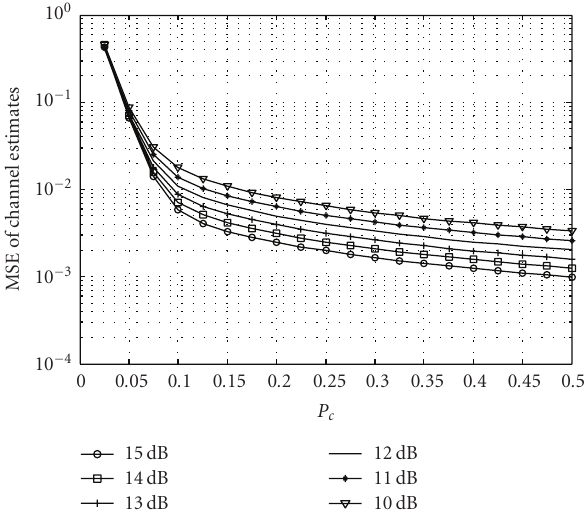
Figure 9: MSE of channel estimates versus power fraction for training signal.